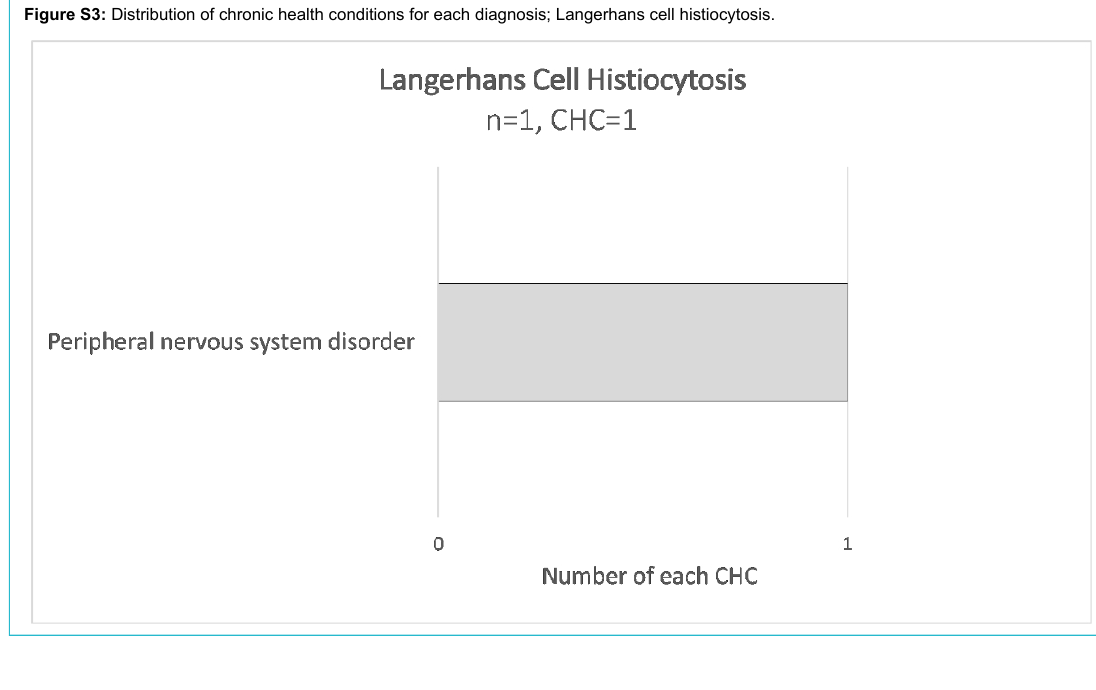
Figure S3: Distribution of chronic health conditions for each diagnosis; Langerhans cell